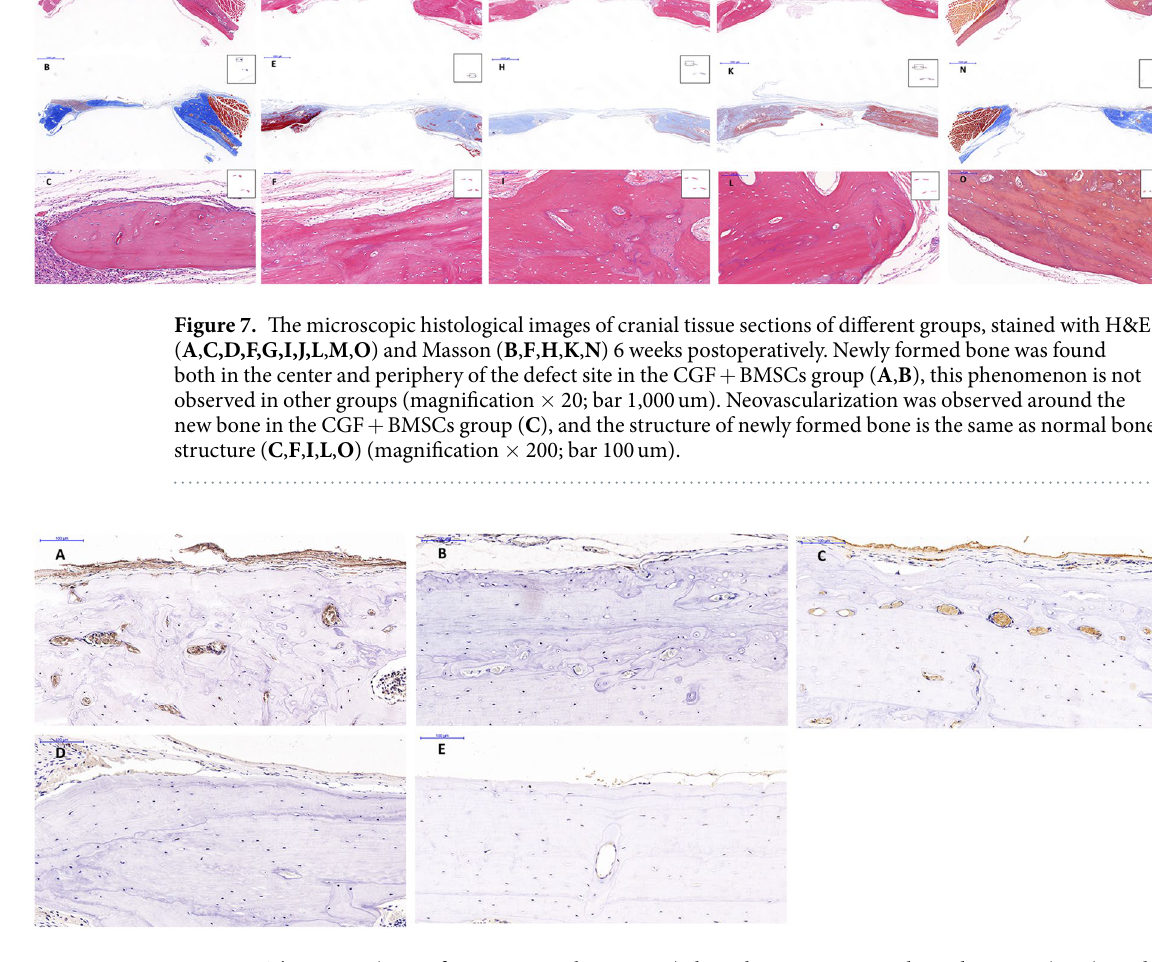
Figure 8. The images (magnification × 200; bar 100 um) show the CD34 immunohistochemistry (IHC) results. Contrary to the ( B ) collagen + BMSCs, ( D ) collagen and ( E ) blank groups, neovascularization was observed in the ( A ) CGF + BMSCs group and also in the ( C ) CGF group. However, neovascularization in the ( C ) CGF group was less than in the ( A ) CGF + BMSCs